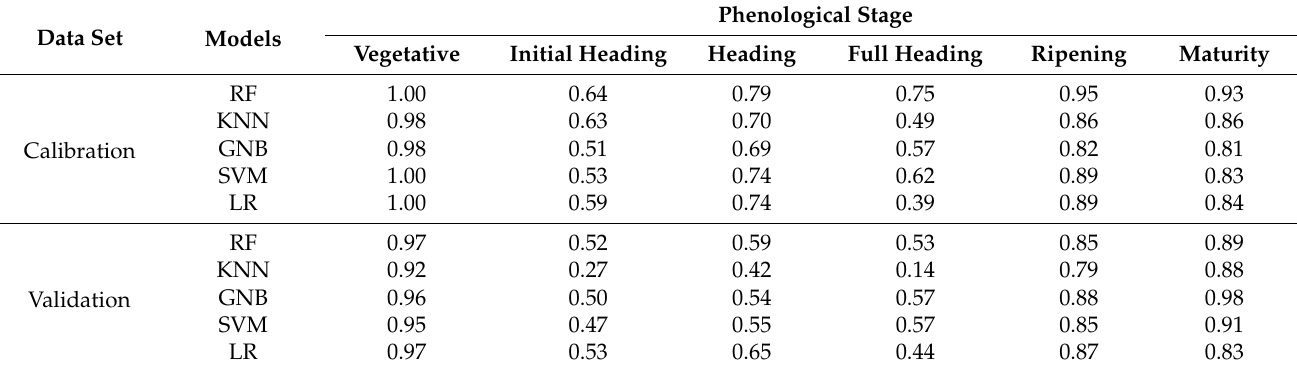
Table 3. The F1-scores of different machine learning models for detecting phenology in calibration and validation datasets. Data Set